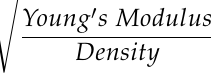
Table 2. Resistivity/Conductivity of Metamorphic Rocks.